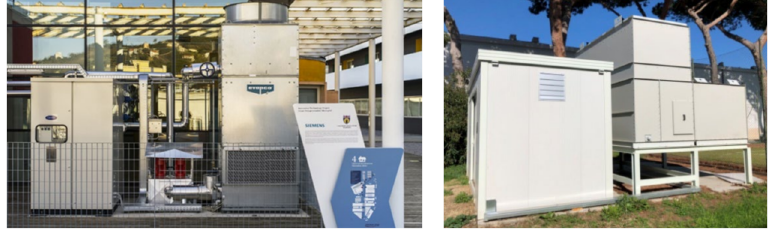
Figure 5. Absorption chillers of the SPM [35].